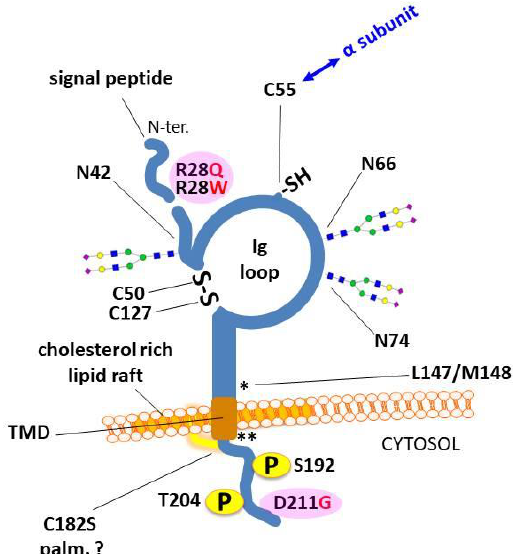
Figure 4. Sequence and domain architecture of the β 2 subunit. Of its 215 amino acids, the first 29 correspond to the predicted N-terminal (N-ter.) signal peptide [41]. It is worth noting the extracellular immunoglobulin (Ig)-like loop. The transmembrane domain (TMD), which expands along ~ 20 residues, and probably associates with lipid rafts, is followed by a short C-terminal domain. Asterisks denote the approximate location of cleavage sites by β -secretase (*) and γ -secretase (**). Pathogenic mutations, i.e., the atrial fibrillation-associated R28Q and R28W, and the BrS-associated D211G, are shown in pink background; see the text for more details.